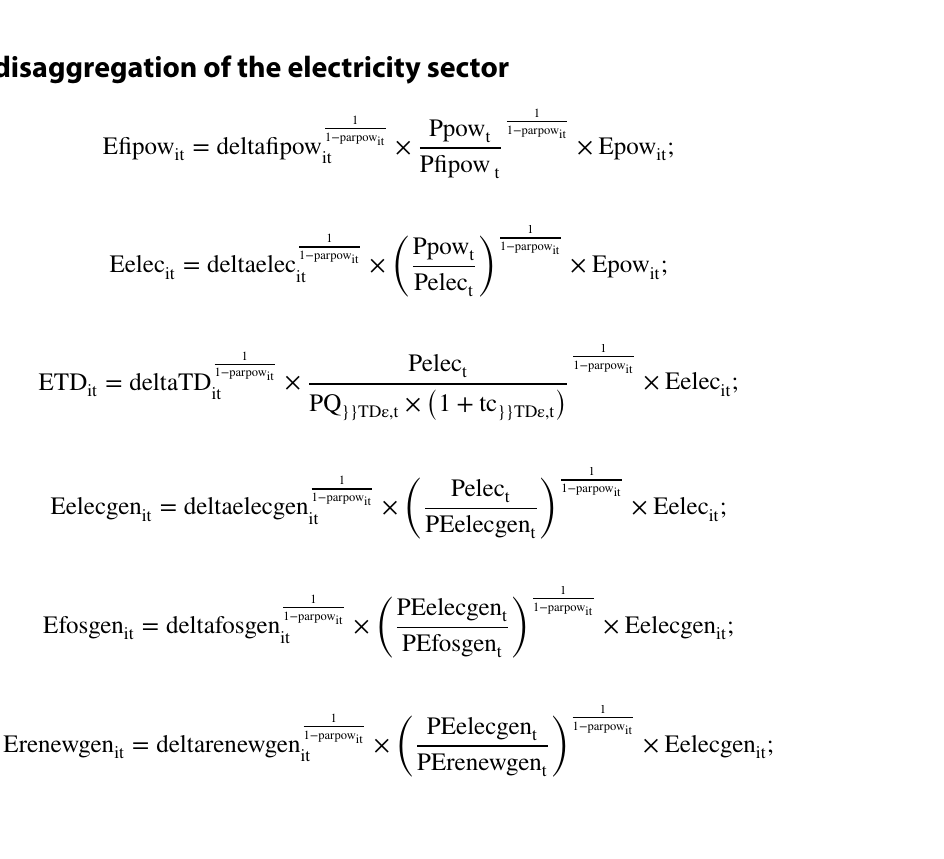
Fig. 14 The technical index in the baseline and tax